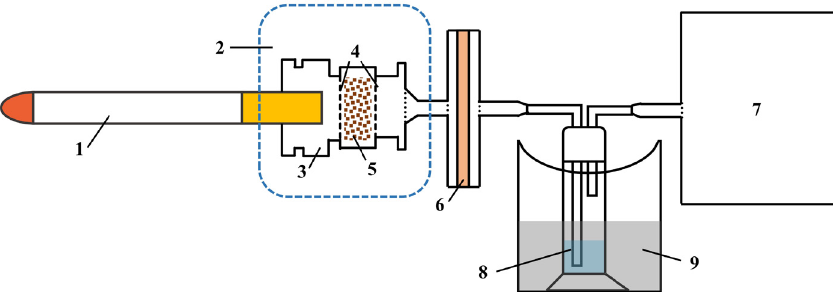
Figure 1: Device to simulate the addition of absorbents to the cigarette fi lter; 1 – cigarette, 2 – homemade device, 3 – cigarette holder, 4 – 120 mesh sieves, 5 – samples, 6 – Cambridge fi lter pad, 7 – smoking machine, 8 – absorption fl ask with 15 mL of methanol, 9 – cold trap containing isopropanol and